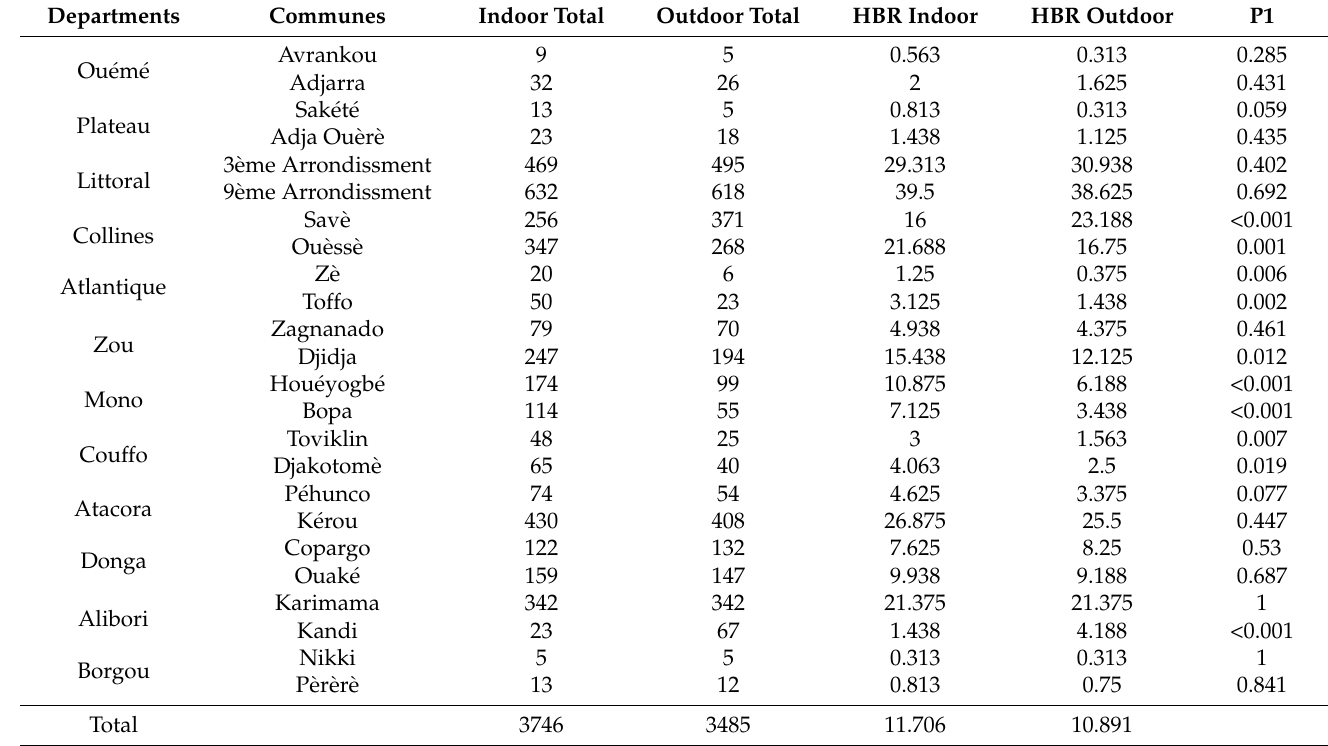
Table 2. Indoor versus outdoor biting rates by commune and department.